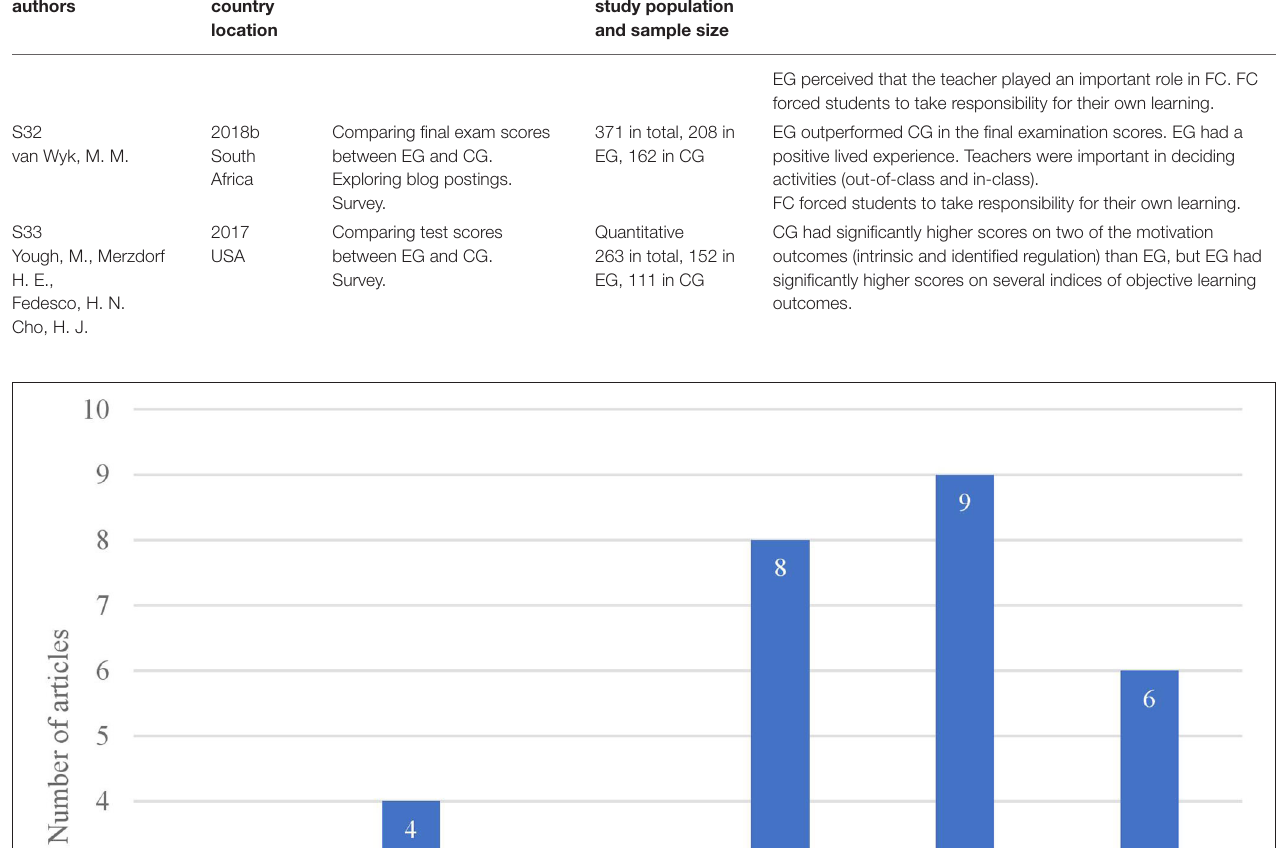
that 22 (67%) of the studies used mixed methods for data collection, 8 (24%) used quantitative methods, and 3 (9%) used qualitative